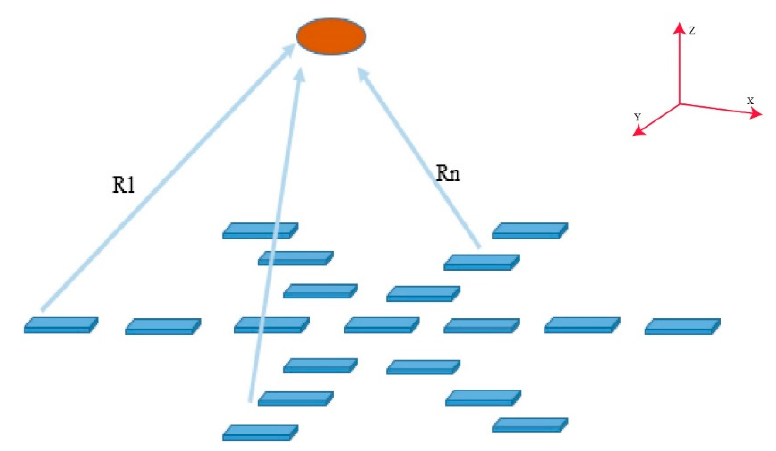
Figure 4. Circular distribution array diagram.